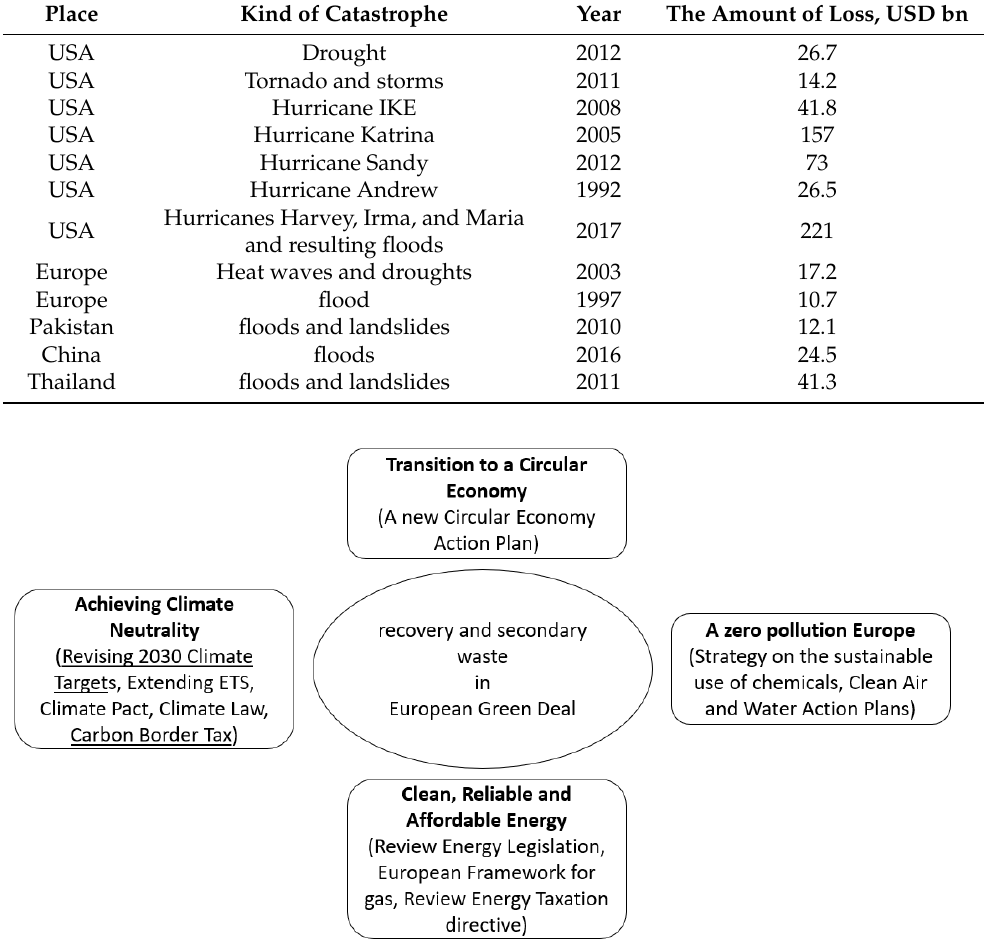
Figure 1. Selected European Green Deal projects that include climate and environmental protection.